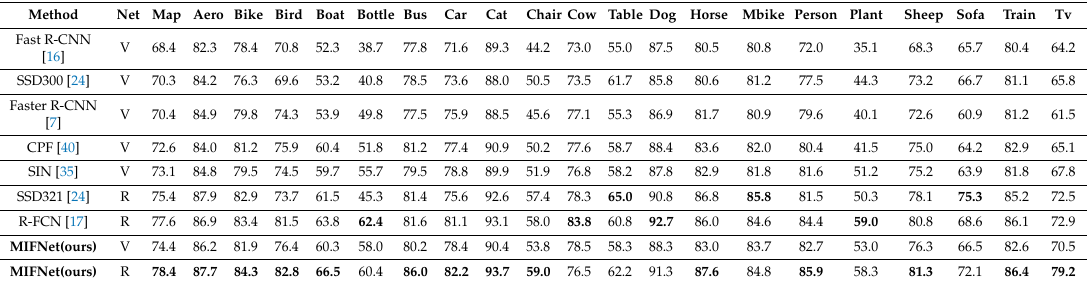
Table 3. Detection results on PASCAL VOC 2012 test. Train set: 07trainval + 12trainval + 07test. “V” and “R” denote the model uses VGG-16 and Resnet-101 as backbone networks, respectively. The bold characters represent the best result for each